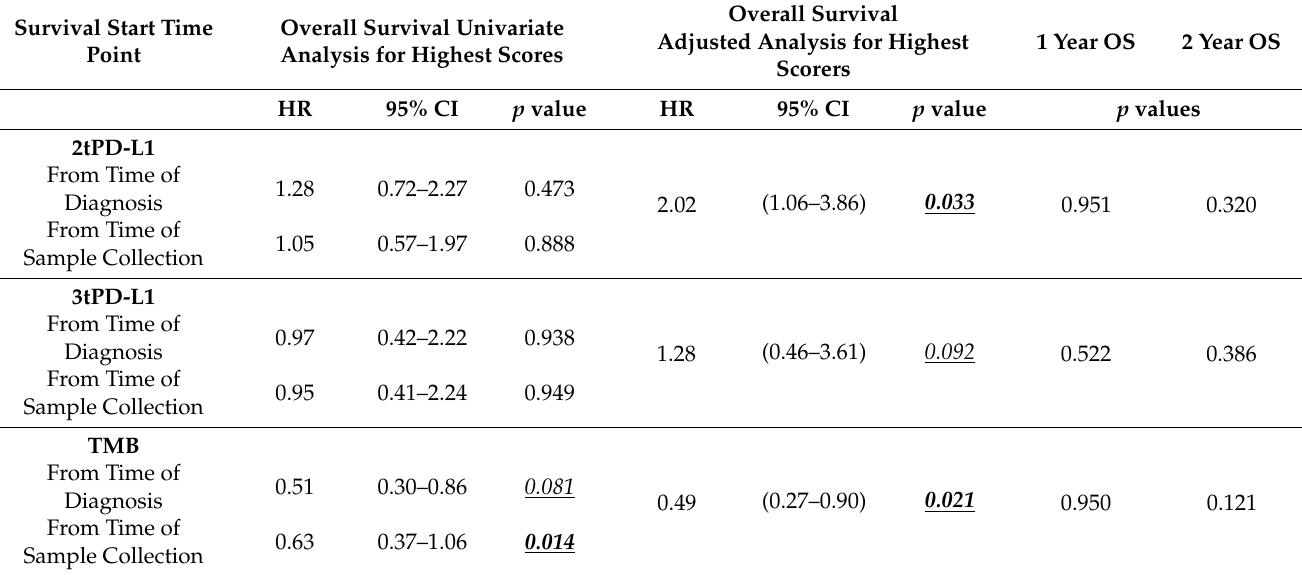
Table 3. Association of high PD-L1 expression and TMB with survival outcomes.